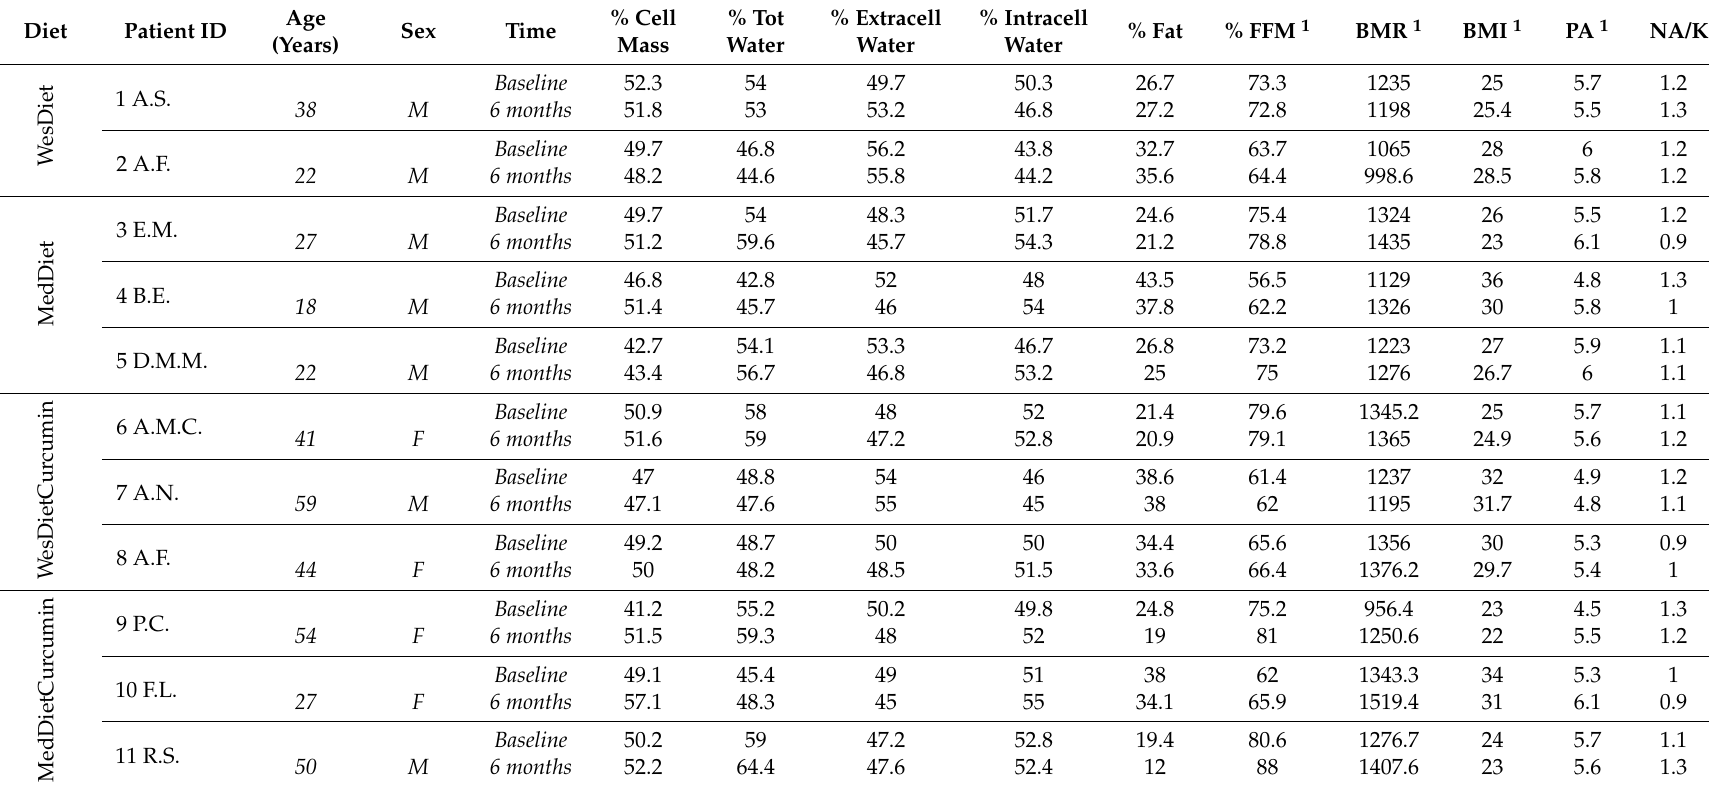
Table 2. Bioimpedentiometric and metabolic analysis in the course of